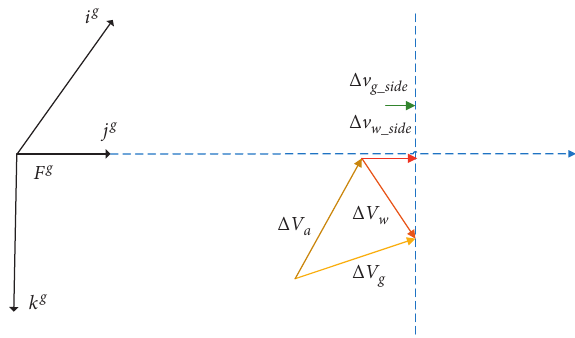
Figure 3: The relationships of the different velocity